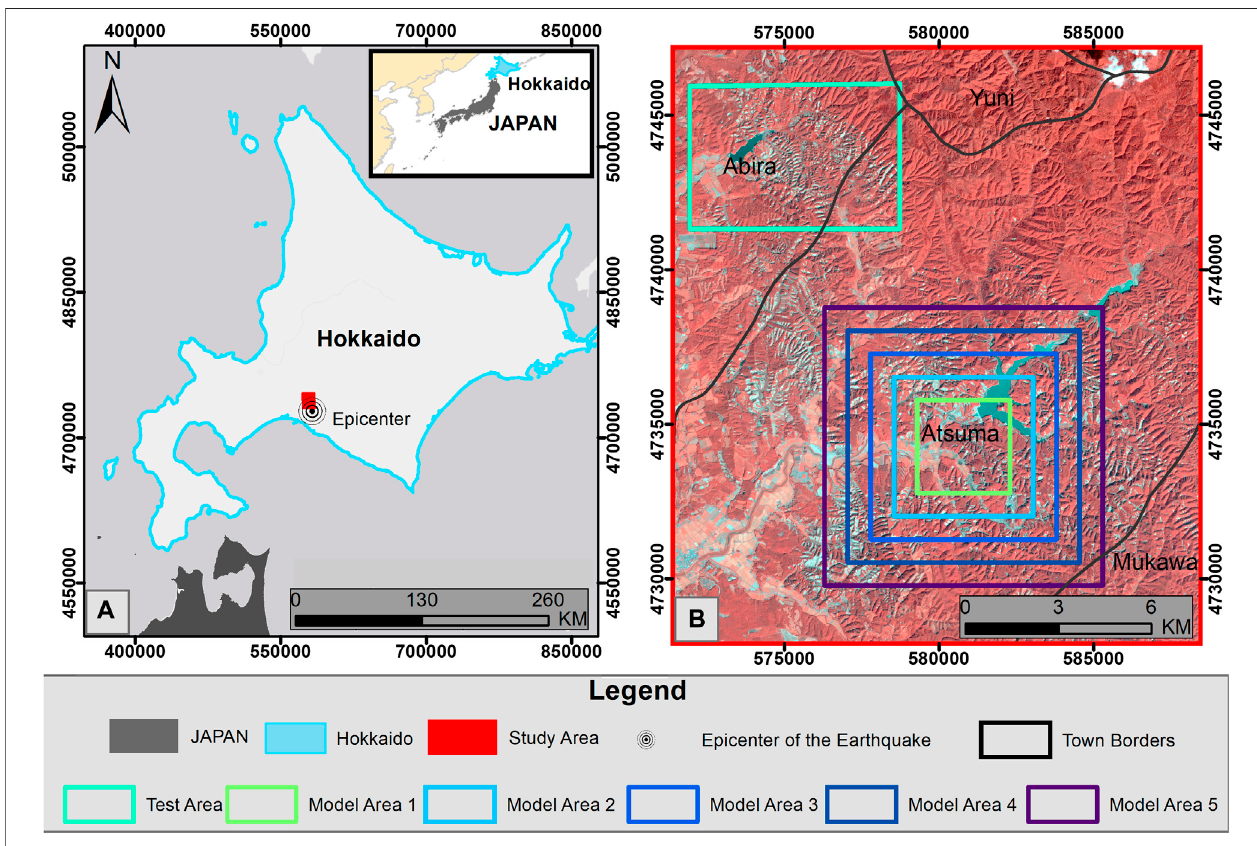
FIGURE 1 | The study area selected for analysis: (A) The location of the epicenter of the earthquake and the study area (red polygon) in Hokkaido, (B) Model development and test areas determined for landslide mapping.